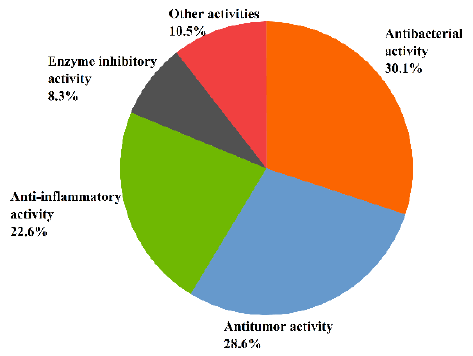
Figure 4. The bioactivity of sesquiterpenoids from Aspergillus sp.